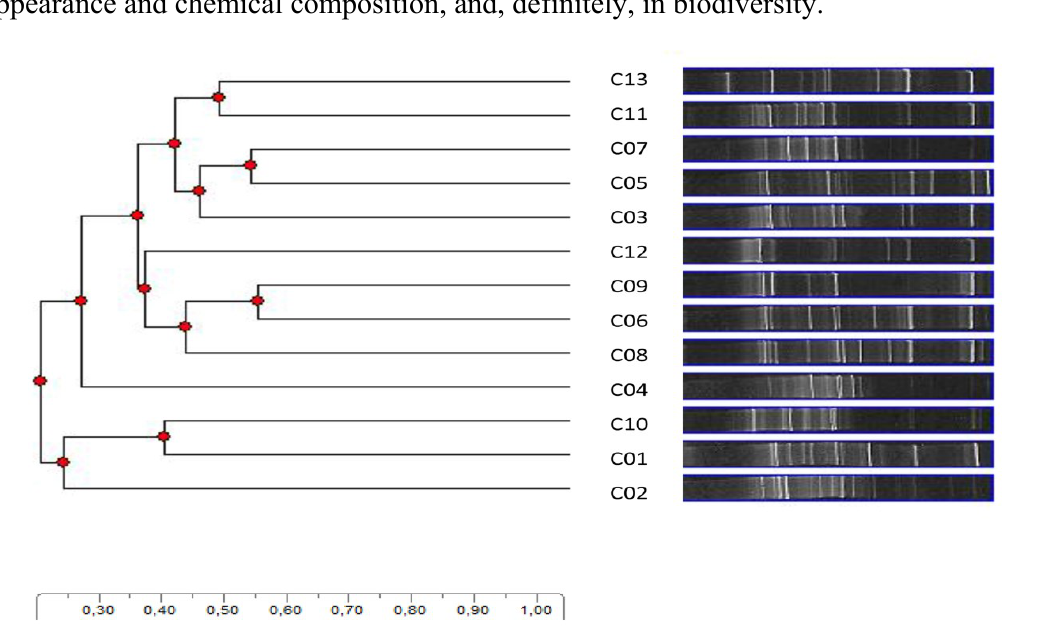
Figure 5. UWPGMA analysis of the DGGE profiles of the fungal